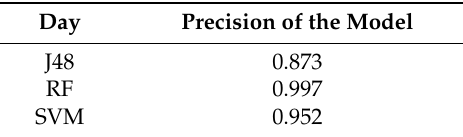
Table 6. Precision results of each model.